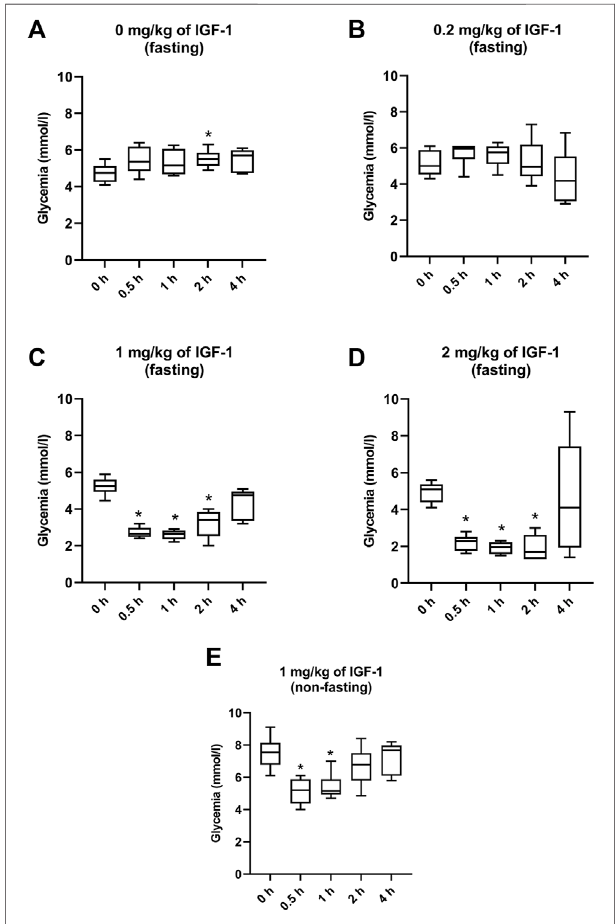
FIGURE 1 | Effect of IGF-1 on mouse glycemia. (A) mice fasting for 12 h before the experiment administered with physiological saline. (B) mice fasting for 12 h before the experiment administered with IGF-1 at a dose of 0.2 mg/kg. (C) mice fasting for 12 h before the experiment administered with IGF-1 at a dose of 1 mg/kg. (D) mice fasting for 12 h before the experiment administered with IGF-1 at a dose of 2 mg/kg. (E) non-fasting mice administered with IGF-1 at a dose of 1